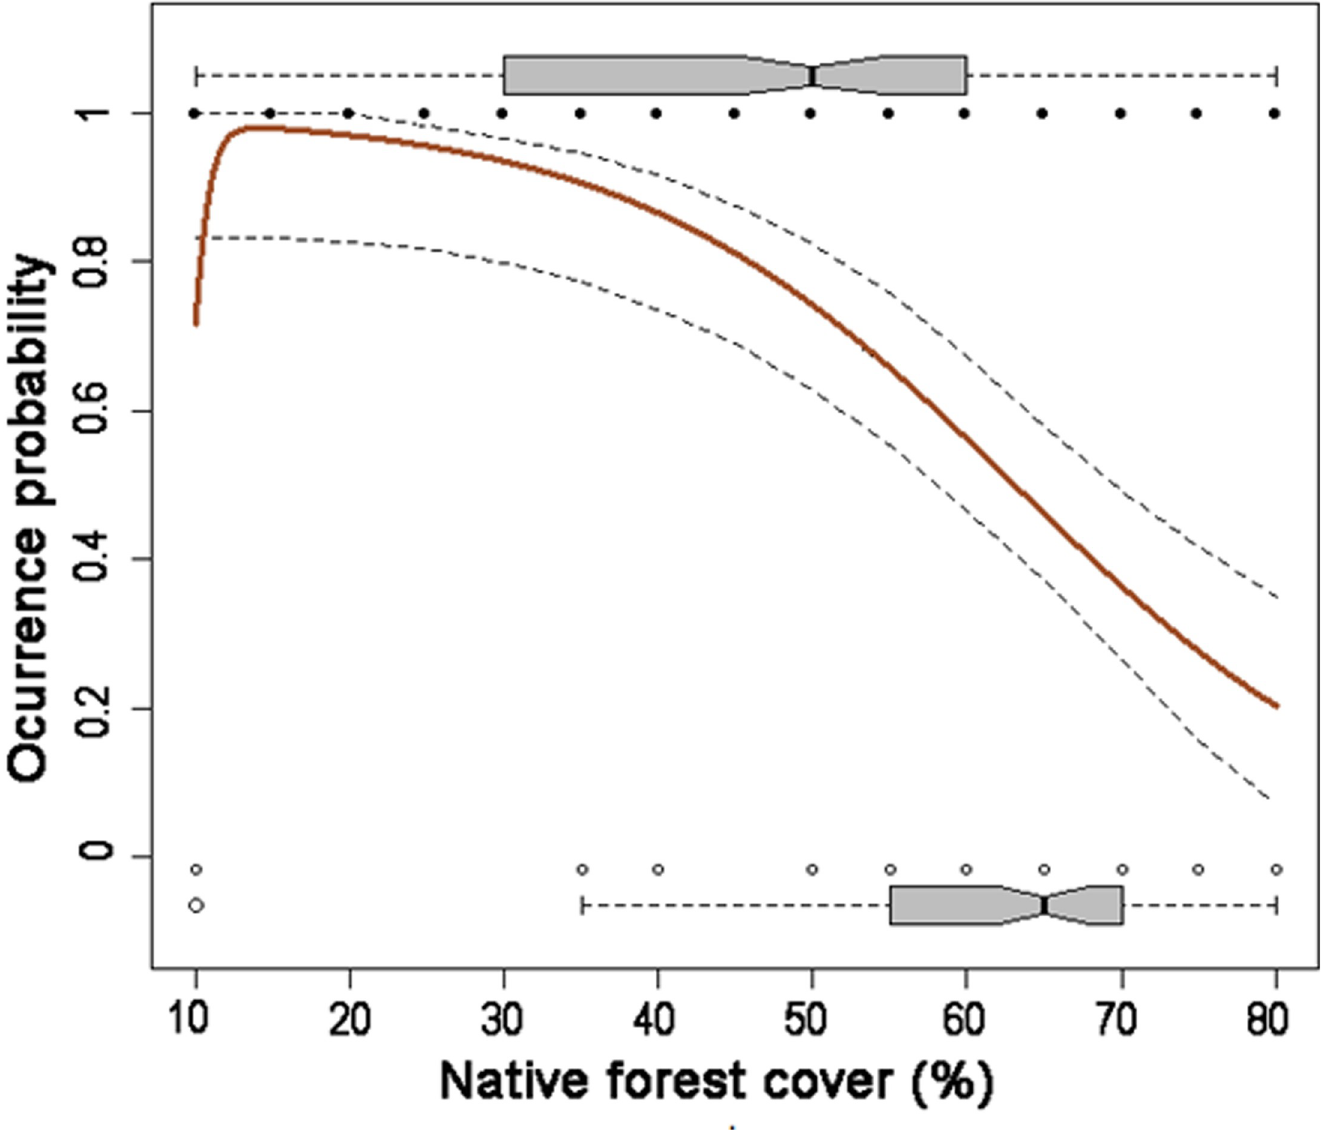
Fig 4. Logistic regression analysis relating forest canopy cover and occurrence probability P(O) of Pinus radiata seedlings in the Coastal Maulino forest. Red line describes the model; dashed lines are 95% confidence intervals. Black dots are presences; white dots are absences. For more clarity and practical use, we decided to relate P(O) with values of native forest cover directly. The analysis was conducted with n = 162 plots.